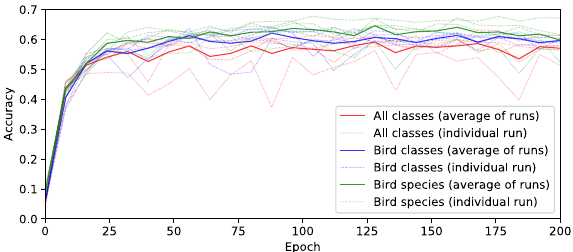
Figure 1. Accuracy over training epochs for 5 replicated training runs from initial models using default SincNet settings. Different colours indicate different tag selections: “All Classes” include insects, one amphibian, birds and their call type (87 classes), “Bird Classes” include only birds and their call type (77 classes), “Bird Species” does not differentiate by call type (51